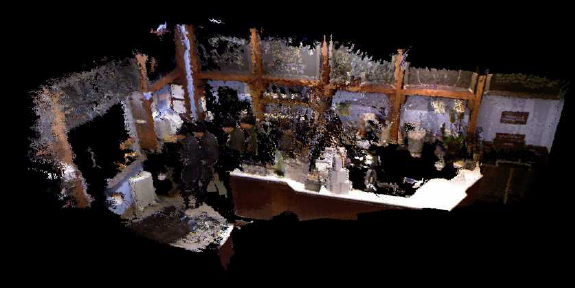
Figure 9. The result of key-frame-based SLAM